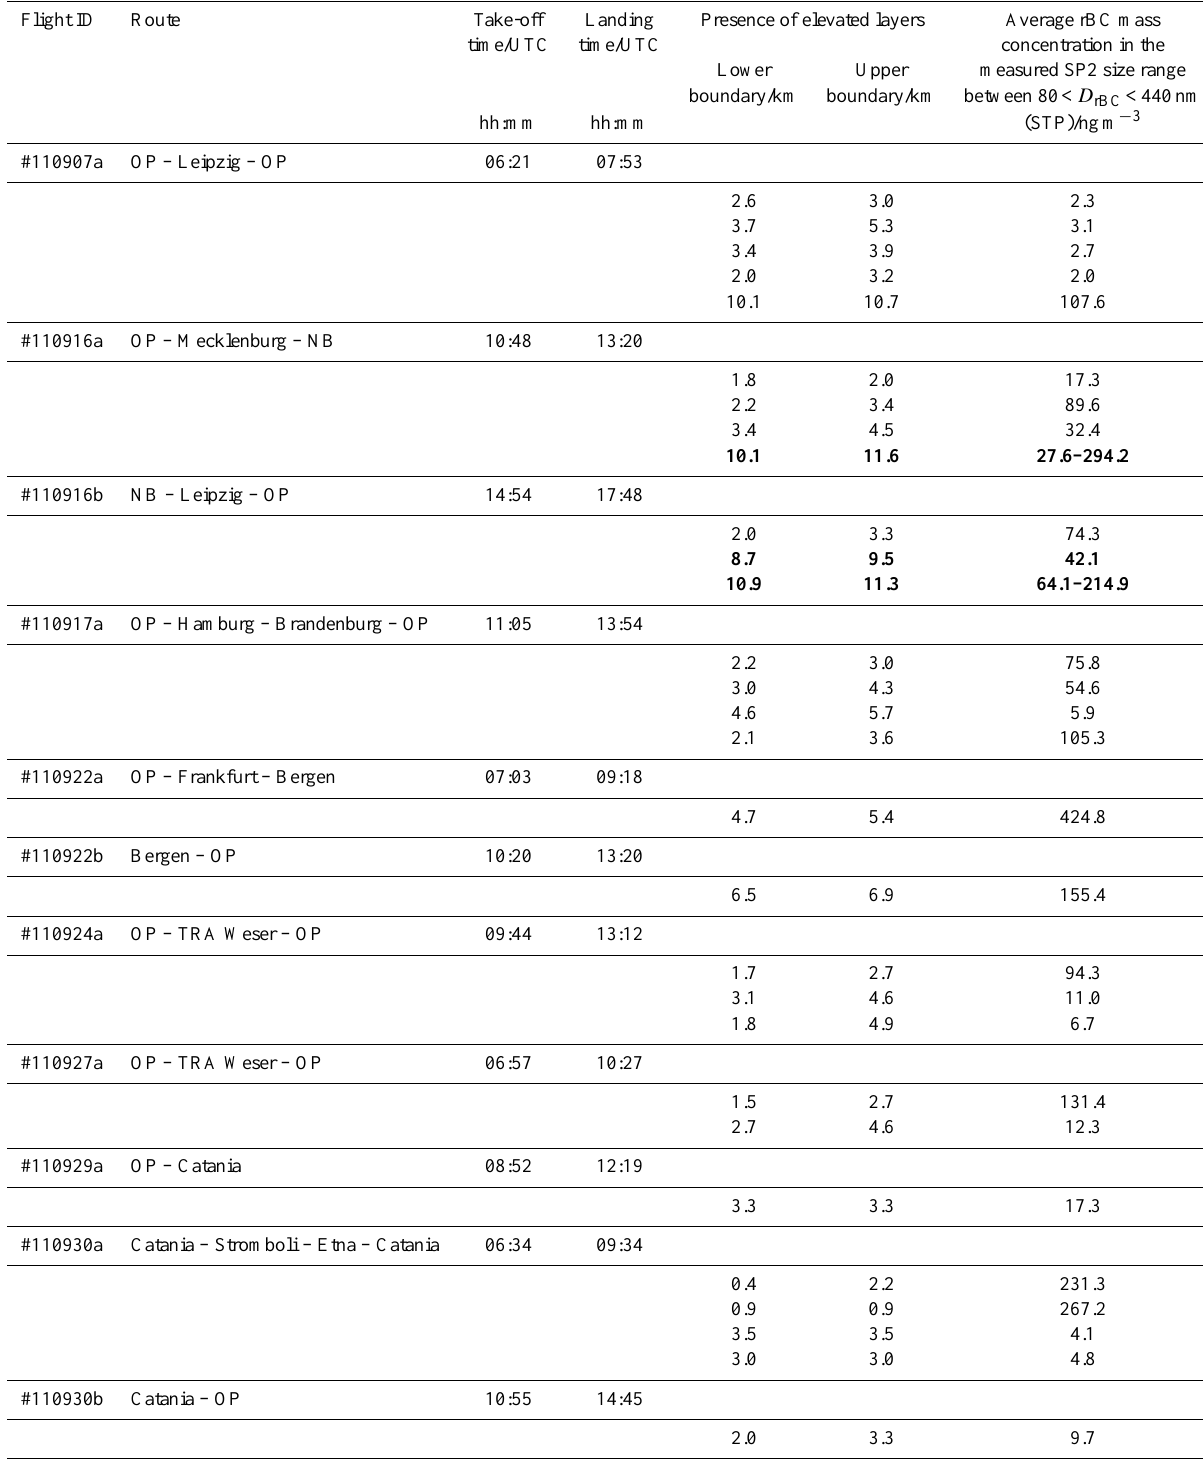
∗ The boundaries are derived from the in situ measurements, representing the minimal vertical depth of the